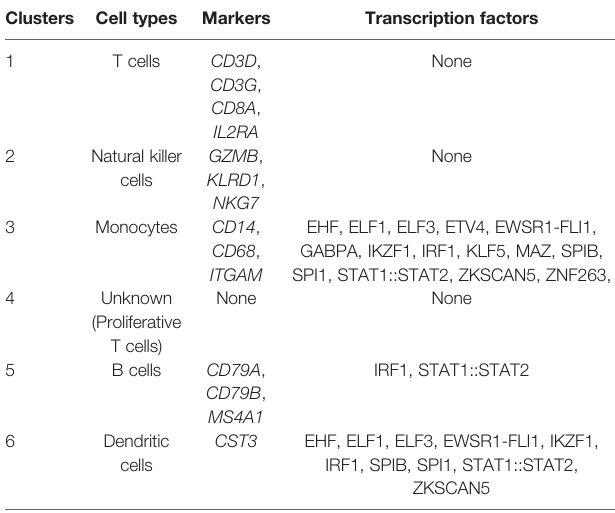
TABLE 2 | Identi fi ed markers and transcription factors in each cluster for scATAC-seq experiments. Clusters Cell types